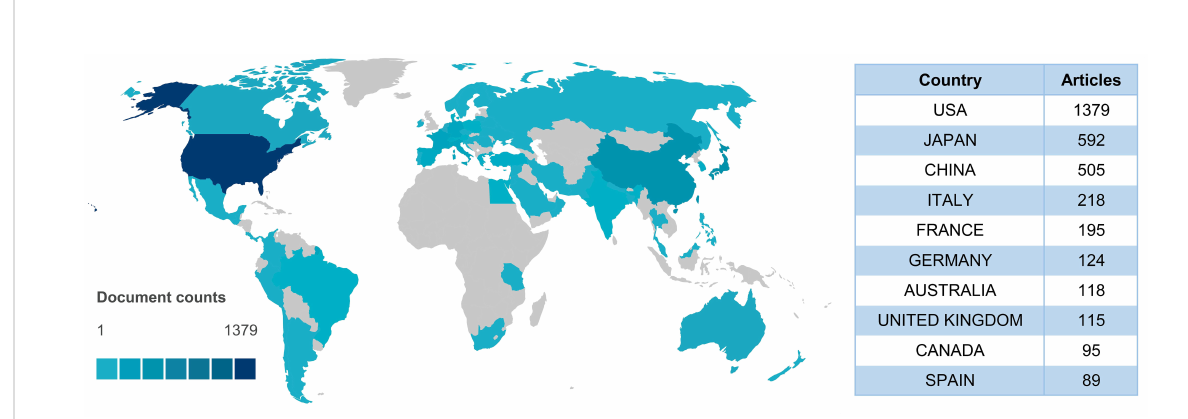
FIGURE 3 An overview of the contributions of each country based on the number of publications.